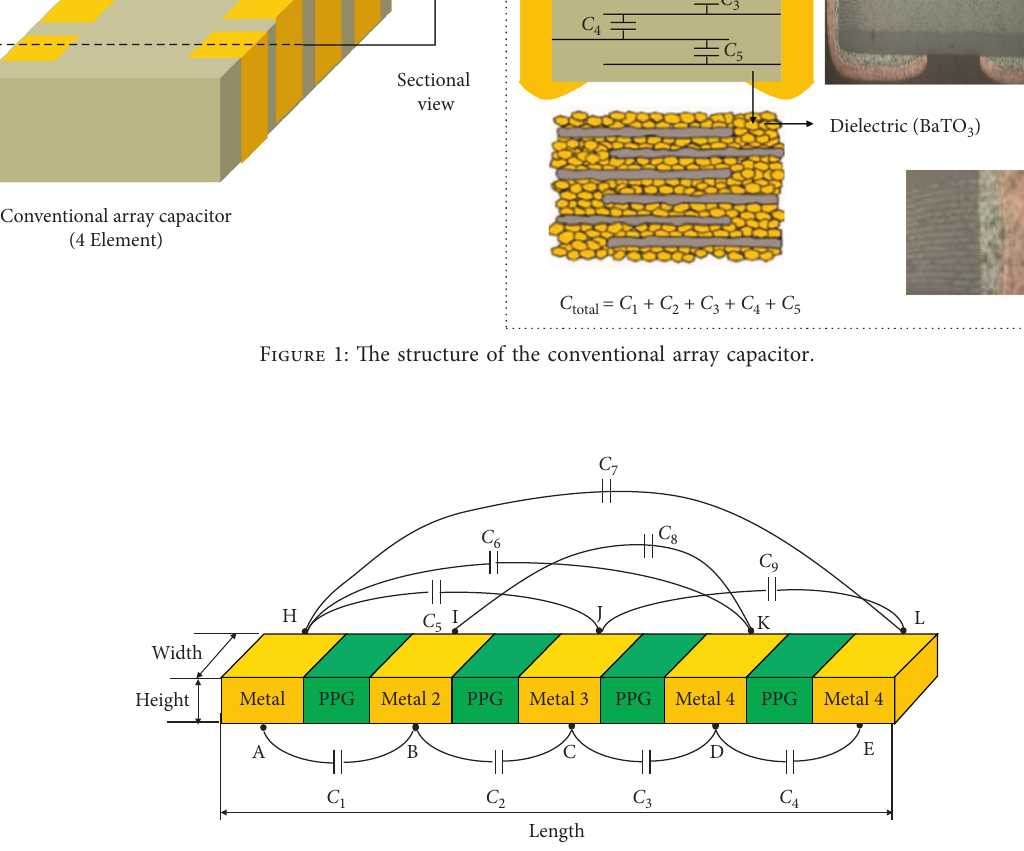
Figure 2: Application example of a horizontal array capacitor with 6 capacitors in single bodies.